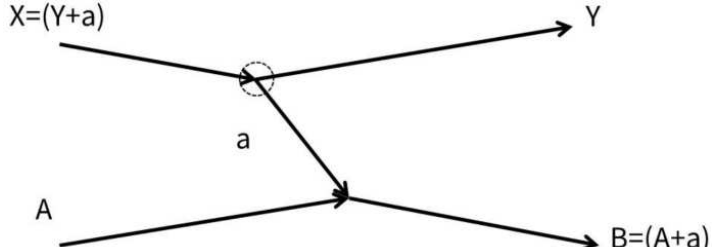
Figure 1. Sketch of a typical transfer